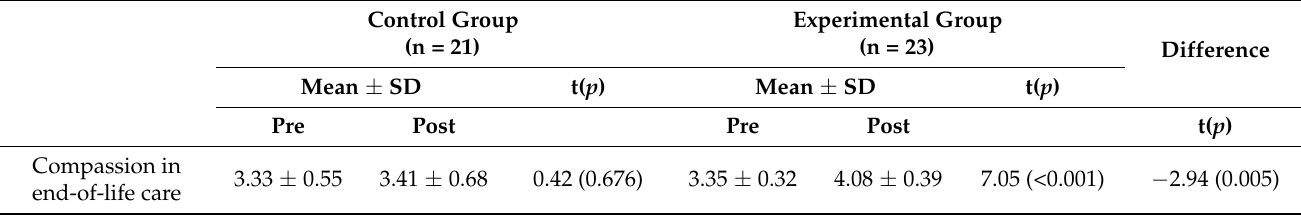
Table 4. Difference in the pre- and post-test scores of compassion in end-of-life care between the experimental group and control